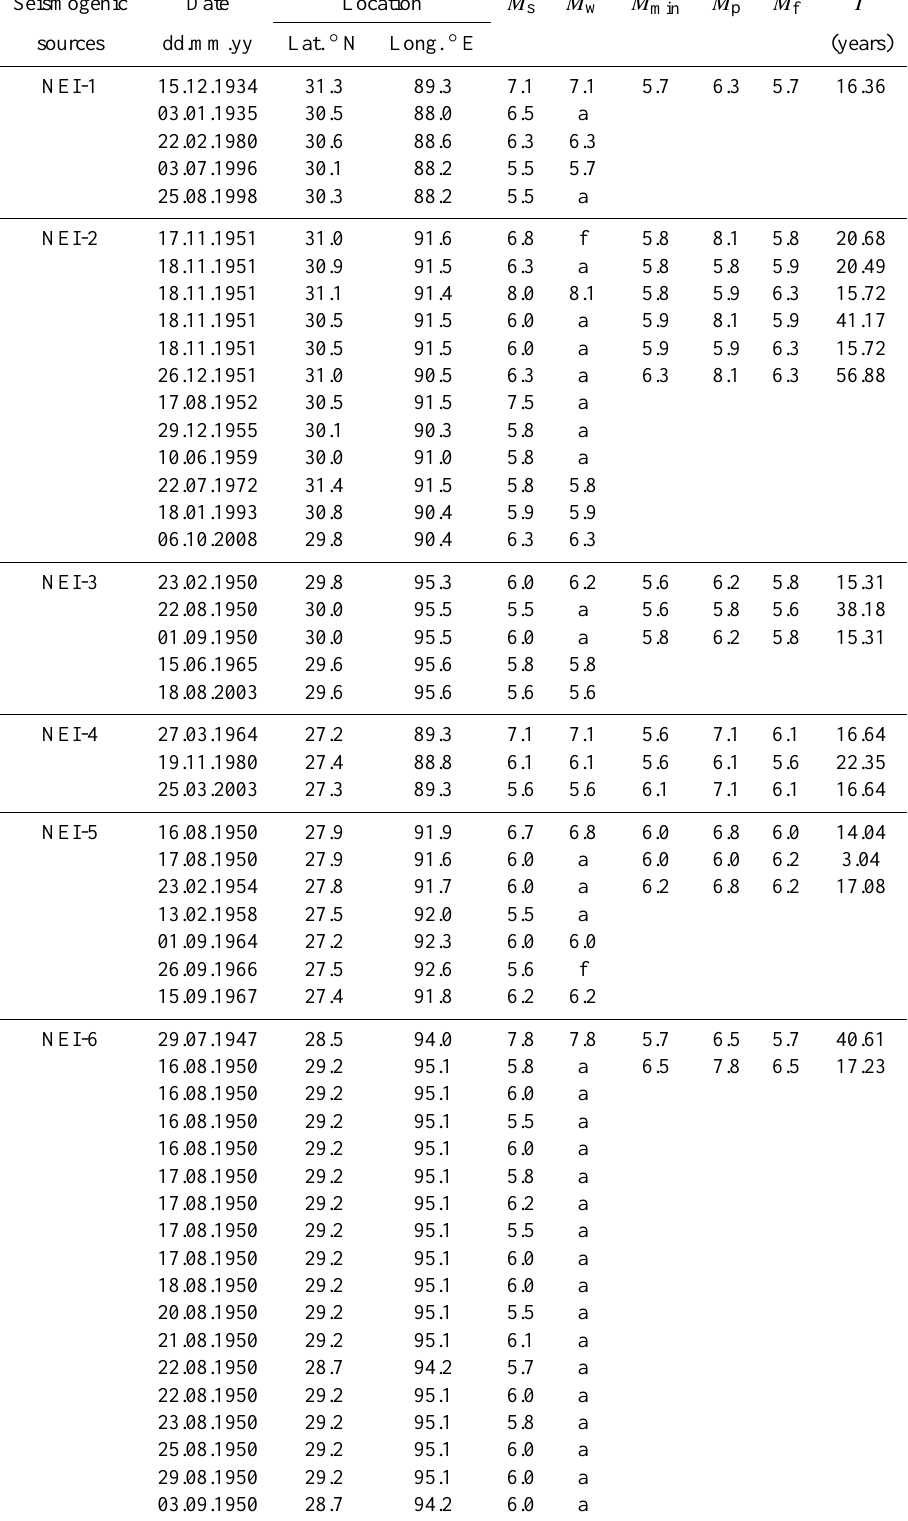
Table 1. Earthquake Data having a magnitude of M s ≥ 5 . 5 used for testing the validity of Time- and Magnitude-Predictable Model; a=aftershocks, f=foreshocks, M=cumulative